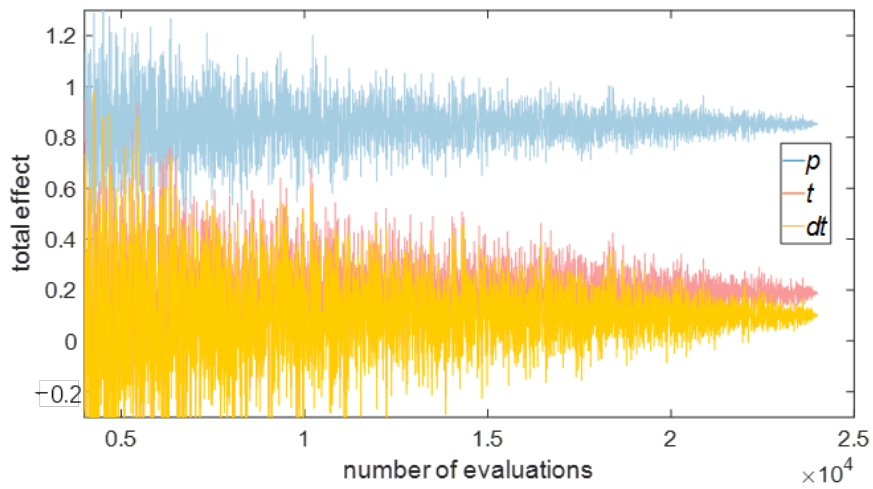
Figure 18. Variation curves of the sensitivity coefficients with the evaluation number.